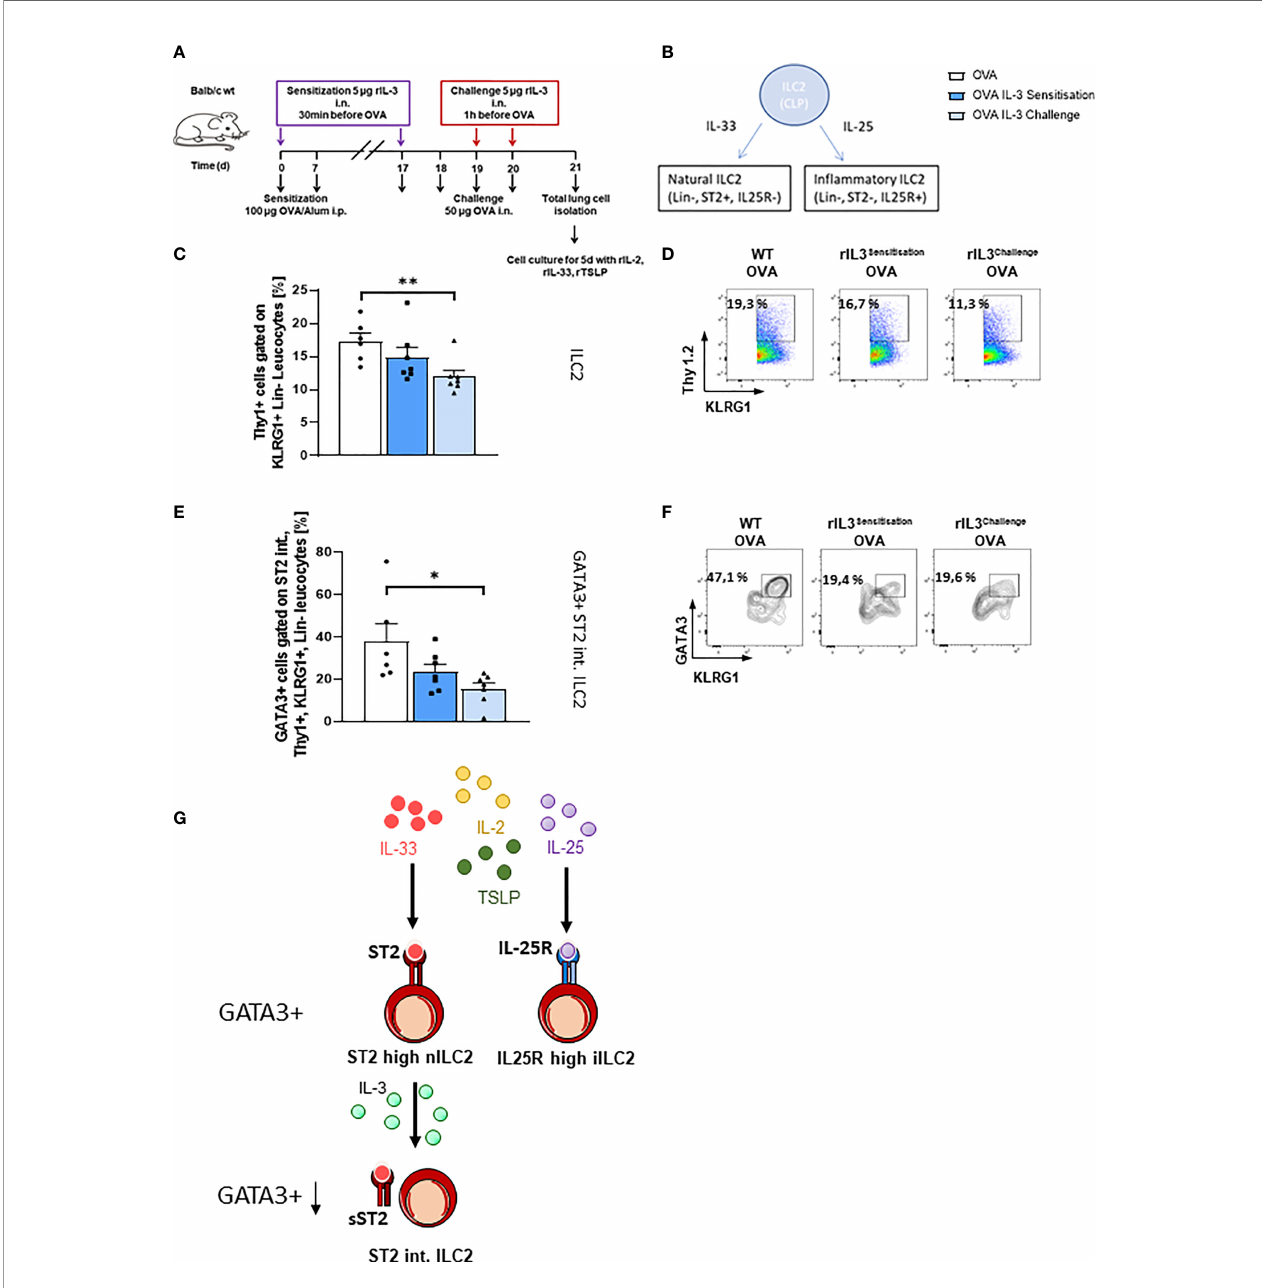
FIGURE 3 | Lung ILC2s in an ovalbumin (OVA)-induced asthma model with intranasal rIL-3 application. (A) Experimental design for the induction of allergic asthma in wild-type (WT) mice treated with rIL-3 for the analysis of lung ILC2s. (B) Cartoon on the differentiation of different ILC2 subpopulations. (C – F) Flow cytometry analysis of ILC2 after in vitro differentiation. Flow cytometry analysis of lung ILC2s (%) (C, D) ; fl ow cytometry analysis of GATA3+ ST2 int . ILC2 (E, F) in the lung of WT mice with asthma and with and without additional rIL-3 treatment during sensitization or challenge phase (n = 6/7/7). (G) Cartoon on the mechanism of IL-3 involvement in ST2 shedding from ILC2. Data are presented as means ± SEMs. One-way ANOVA or Kruskal – Wallis test was used to calculate statistical signi fi cance. *p ≤ 0.05; **p ≤